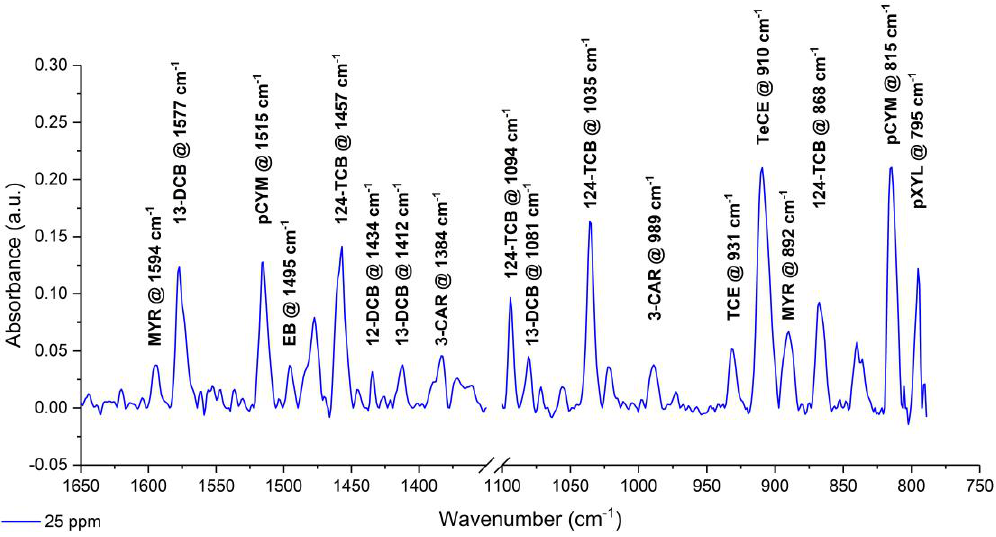
Figure 4. Infrared (IR) absorption spectrum of 10 VOCs (i.e., MYR, 13DCB, pCYM, EB, 124TCB, 12DCB, CAR, TCE, TeCE, and pXYL) in seawater measured simultaneously in a concentration of 25 ppm each. The spectrum was recorded after 80 min of enrichment. Table 2. Summary of calibration functions (i.e., linear fit, r 2 -value, LOD and LOQ derived from peak area analysis) over a concentration range from 1 ppm to 25